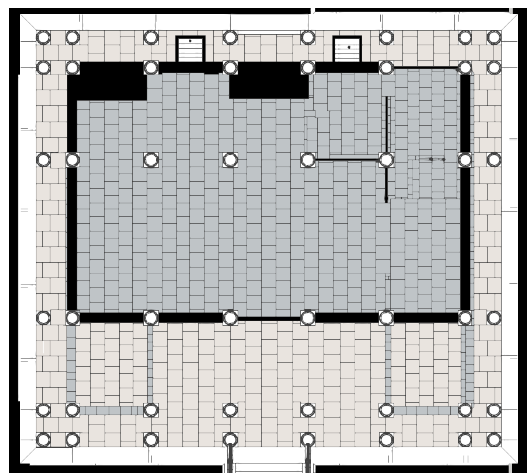
Figure 4. the flat of Jingfu Palace